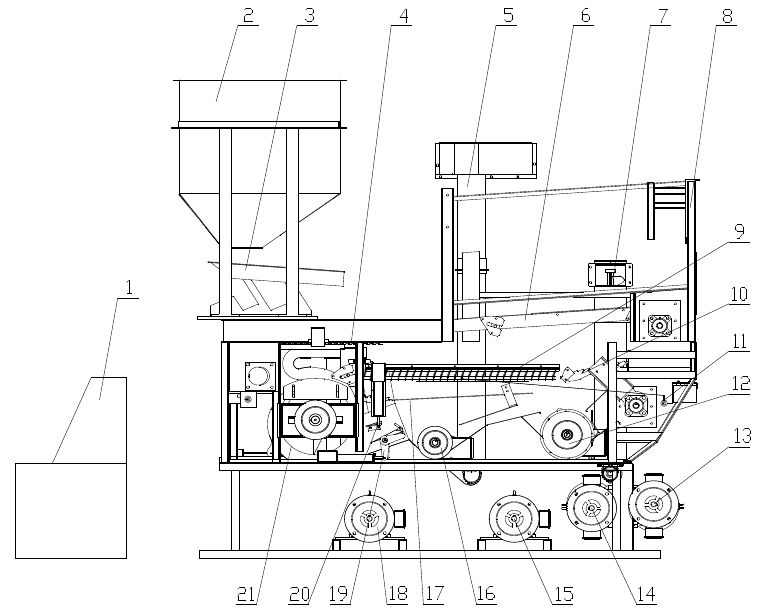
Figure 3. Structure diagram of the cleaning test bench. (1) Control cabinet; (2) feeding device; (3) electromagnetic feeder; (4) oscillating board; (5) vertical grain auger; (6) return board; (7) vertical miscellaneous auger; (8) frame; (9) louver sieve; (10) tail sieve; (11) opening adjustment mechanism of louver sieve; (12) horizontal miscellaneous auger; (13) vibrating sieve drive motor; (14) return board drive motor; (15) grain/miscellaneous auger drive motor; (16) horizontal grain auger; (17) woven sieve; (18) fan drive motor; (19) adjustment mechanism of guide plate I; (20) adjustment mechanism of guide plate II; (21) multi-duct centrifugal fan.